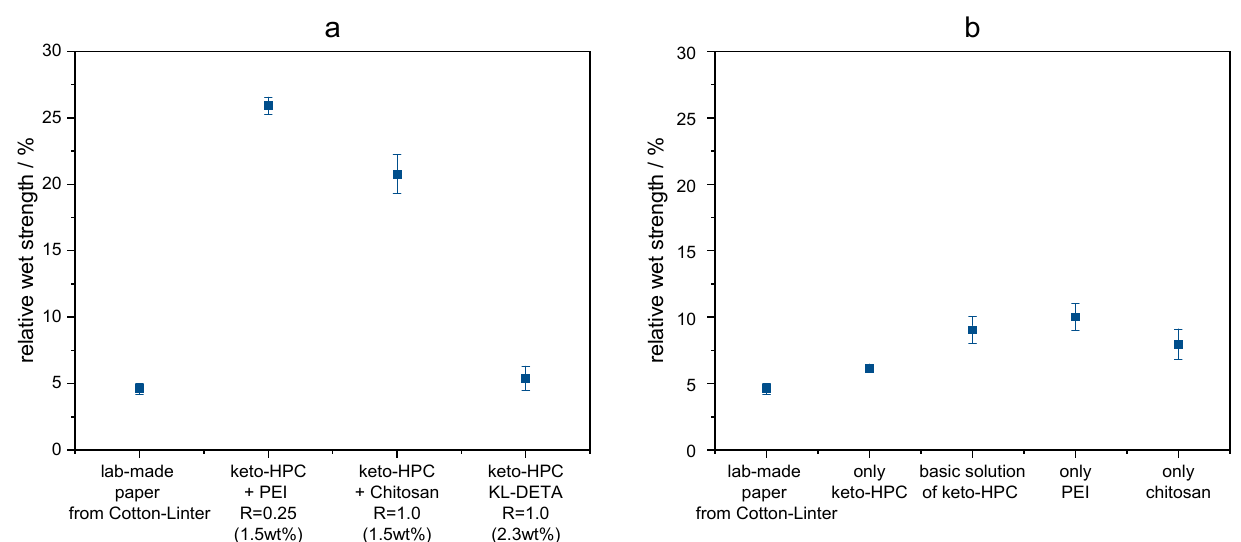
Figure 5. ( a ) Resulting relative wet strength of lab-made paper samples of cotton linters treated with keto-HPC in combination with PEI, chitosan and KL-DETA, respectively. ( b ) Resulting relative wet strength of lab-made paper samples.